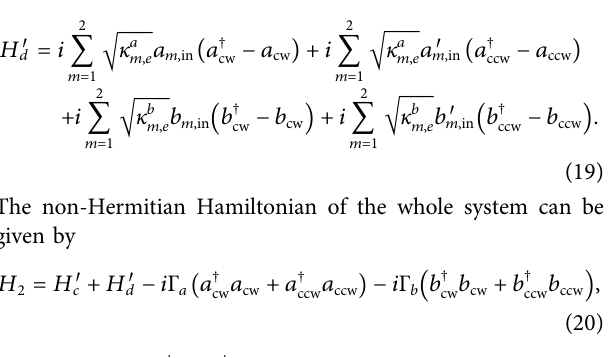
Frontiers in Physics |